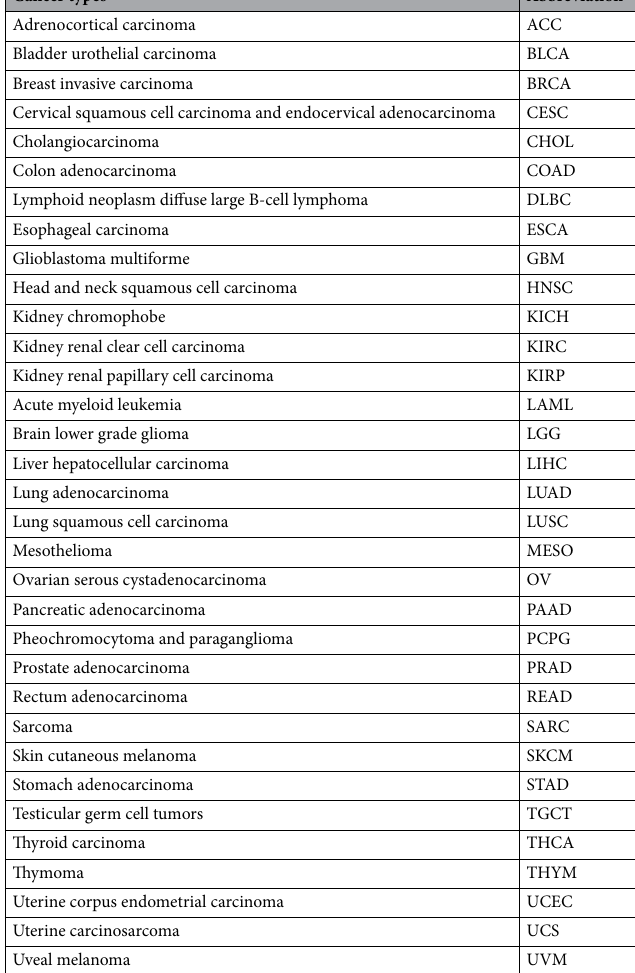
Table 1. The abbreviation of 33 cancer types from TCGA